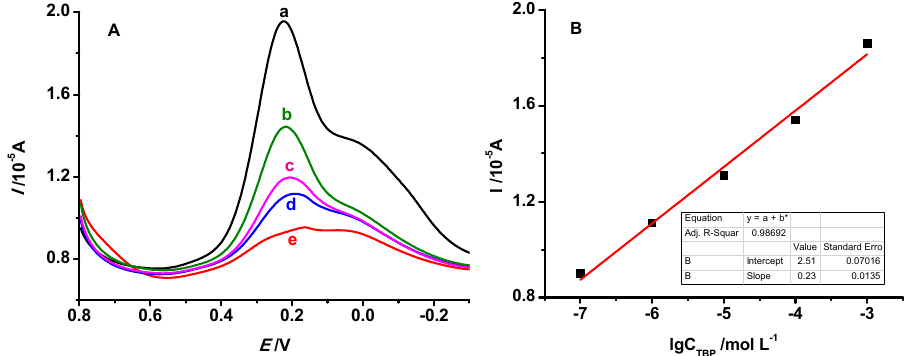
Figure 7. ( A ) DPV of MIP/Au in different concentrations of TBP by electrodeposition (a: 1.0 × 10 − 3 , b: 1.0 × 10 − 4 , c: 1.0 × 10 − 5 , d: 1.0 × 10 − 6 , e: 1.0 × 10 − 7 mol·L − 1 ); ( B ) The linear relation of I– lgC TBP .